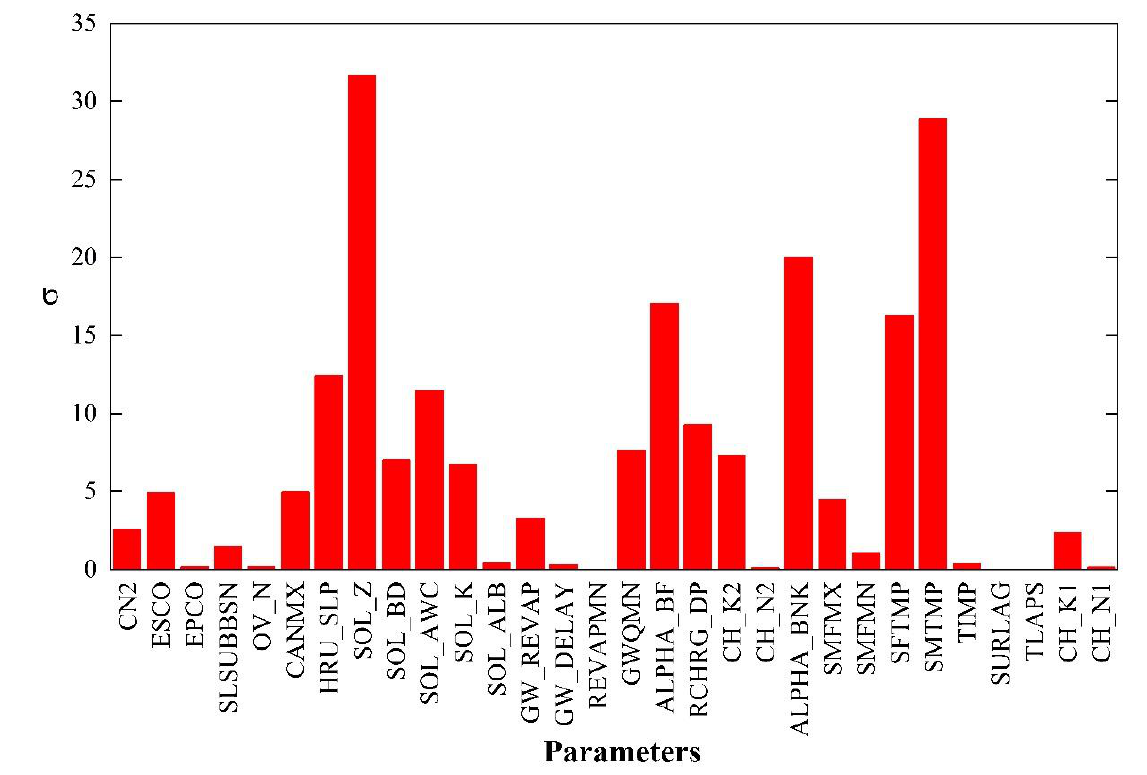
Figure 5. Standard deviation distributions ( 𝜎 ) of each parameter of the Morris screening method.